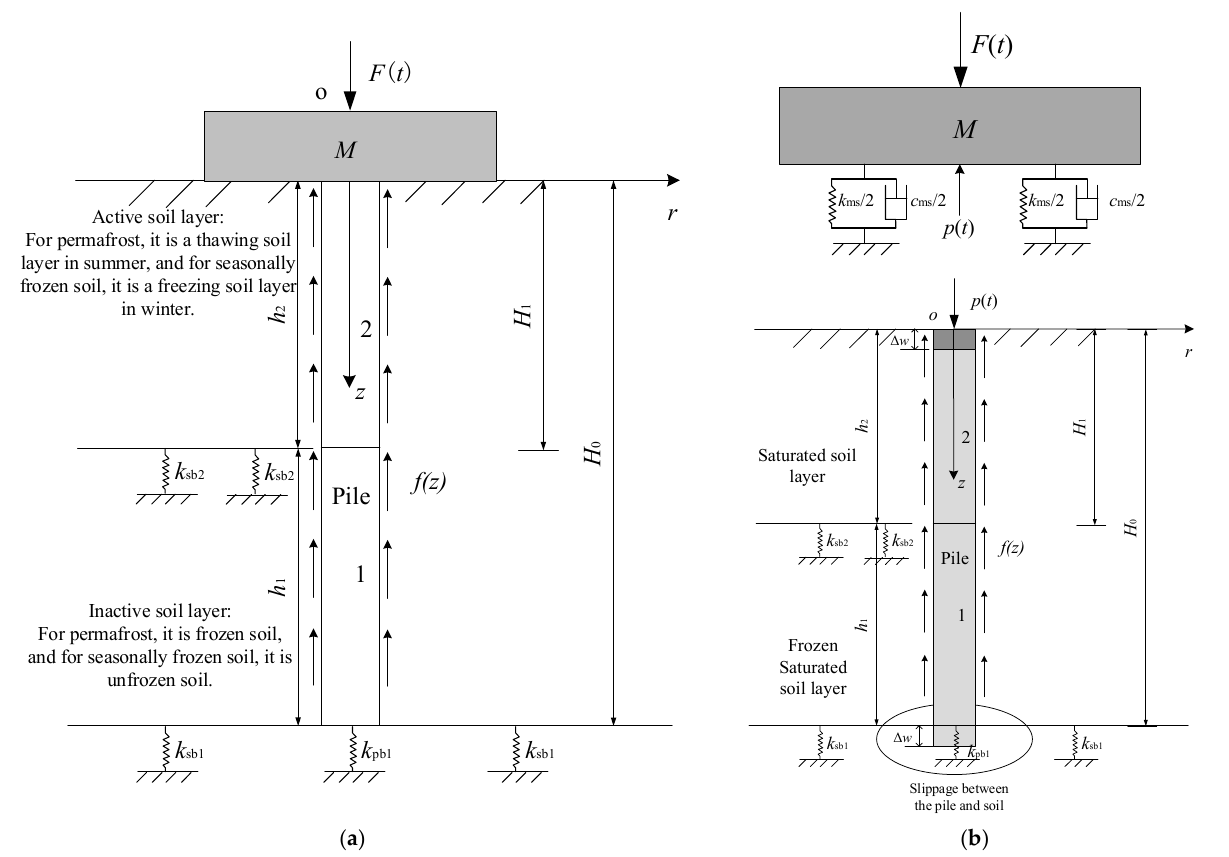
Figure 1. Schematic diagram of model of a pile–soil–cap dynamic interaction system. ( a ) Pile–soil–cap coupling system and ( b ) pile cap and pile–soil system substructure.